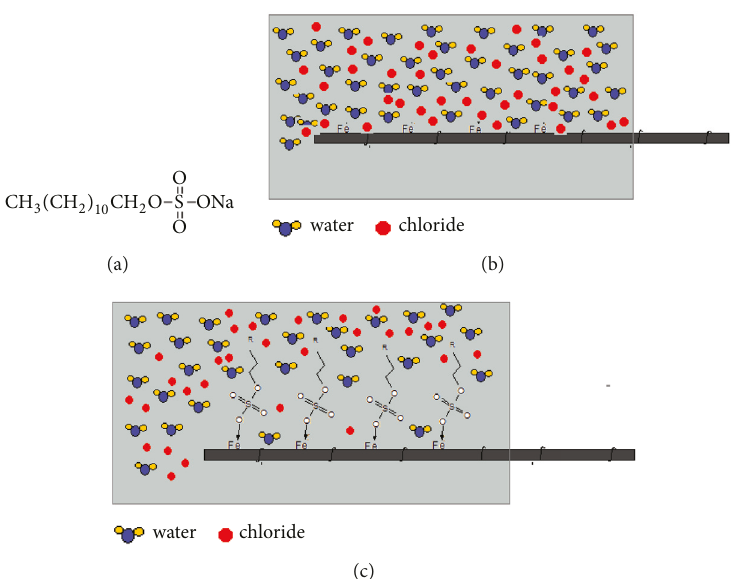
Figure 8: (a) Structureof sodium laurylsulphate;(b) SAMPLE 1: watermoleculesand chloride ions areattachedon steelsurface;(c) SAMPLE 2: coordinated SLS prevent the migration of water molecules and chloride ions towards steel